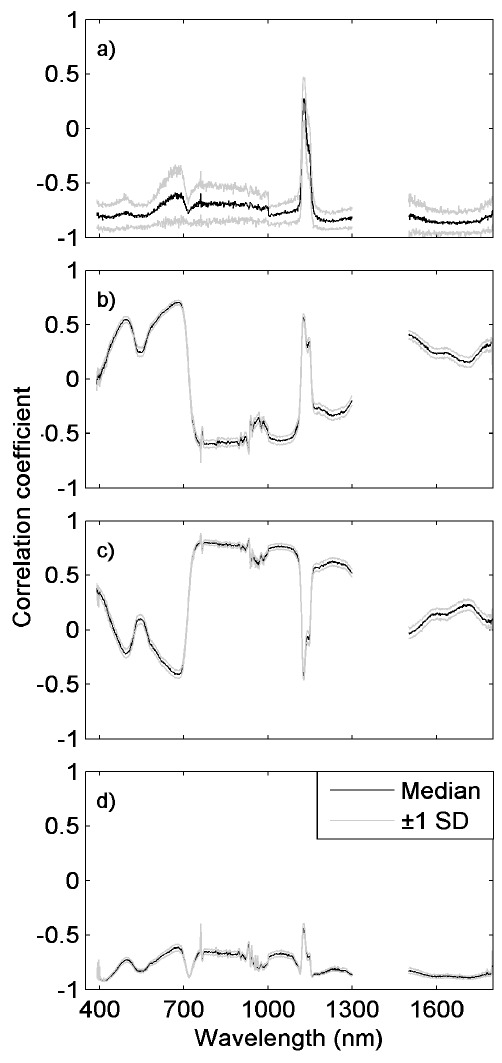
Figure 5. Median correlation coefficient ( ± 1SD) between seasonal dynamics in hyperspectral hemispherical conical reflectance factors (HCRF) 2011–2012 and (a) dry weight biomass ( n = 12; gm − 2 ), (b) gross primary productivity (GPP) ( n = 285; gCday − 1 ), (c) light use efficiency (LUE) ( n = 272; gCMJ − 1 ), and (d) fraction of pho- tosynthetically active radiation absorbed by the vegetation (FA- PAR) ( n = 369). The water absorption band (1300–1500nm)